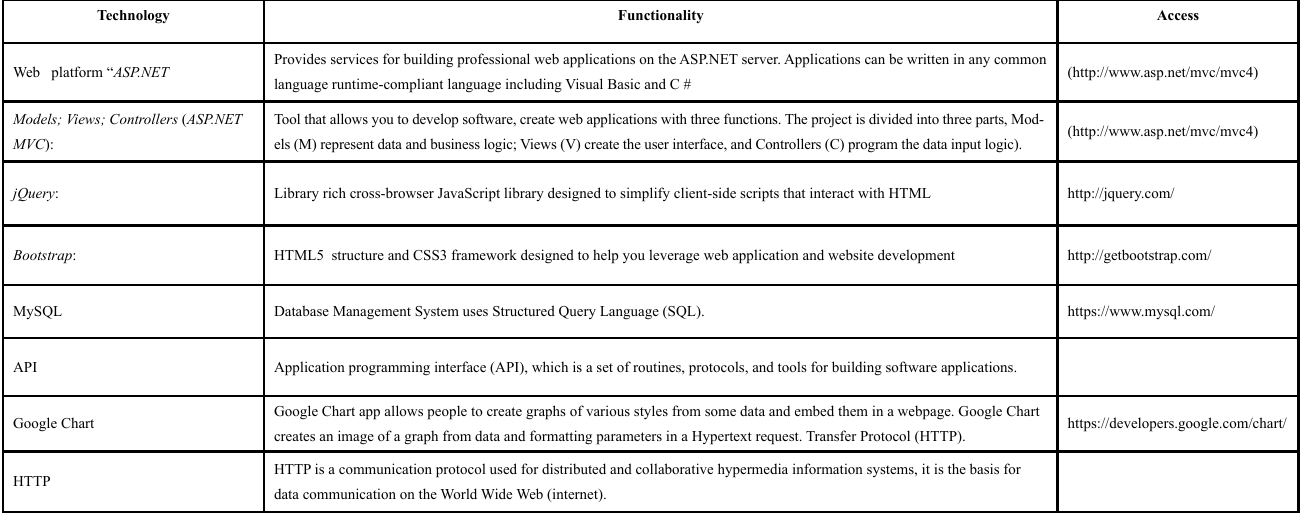
TABLE 1 - List of technologies used in the preparation of the WebCas electronic questionnaire, and access websites. Technology Functionality Access Web platform “ ASP.NET